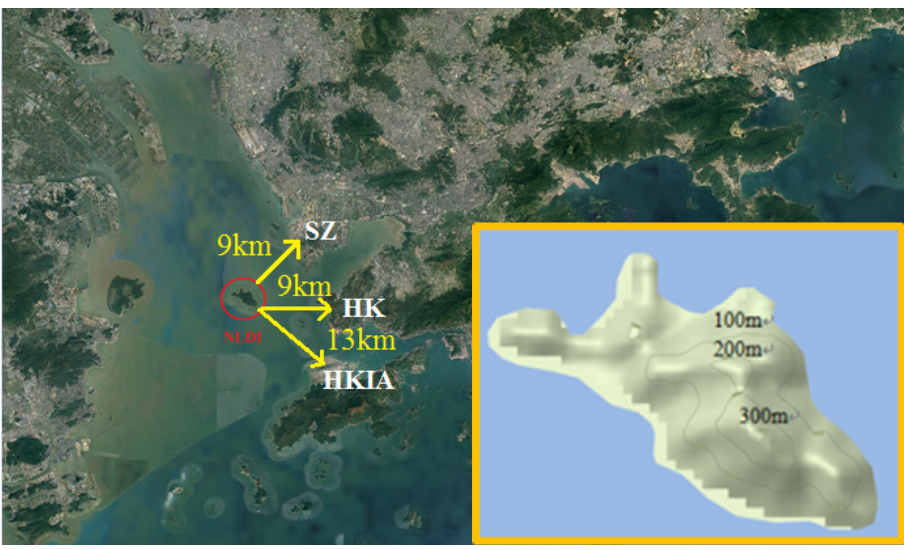
Figure 1. Landscape around NLDI.